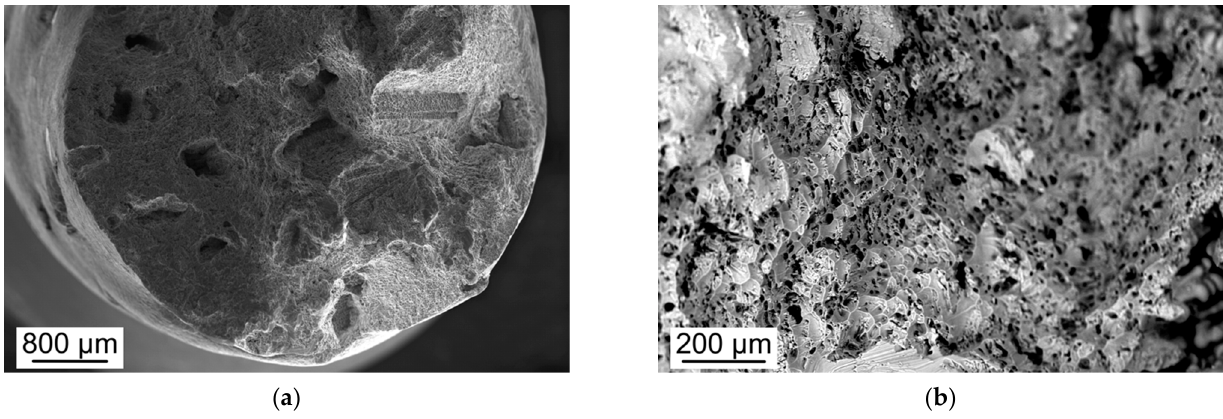
Figure 2. Fracture surface crept specimen in alloy A356 at low ( a ) and high ( b ) magnification, this latter taken with an electron backscattered probe to reveal the presence of phases with high Z-contrast.